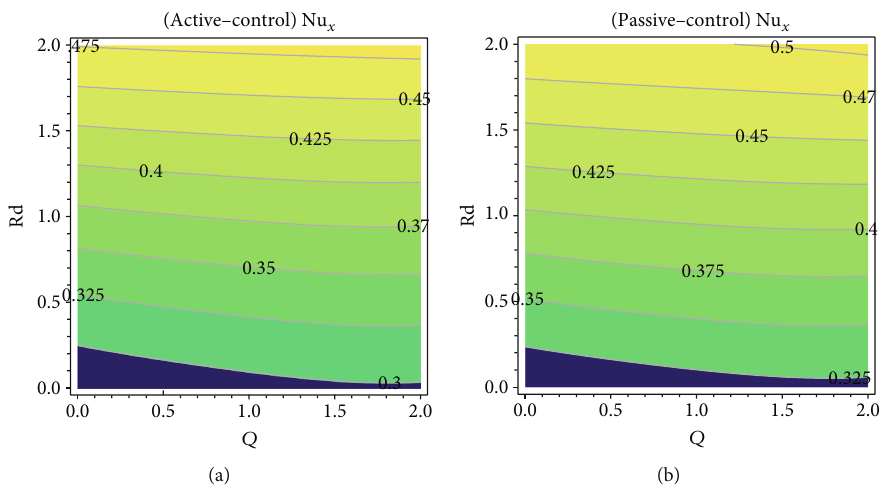
Figure 7: The e ff ect of Nusselt number for combined parameters Rd and Q